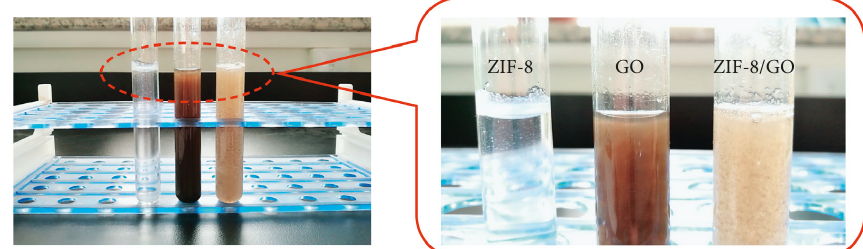
Figure 5: Photograph of different solutions.